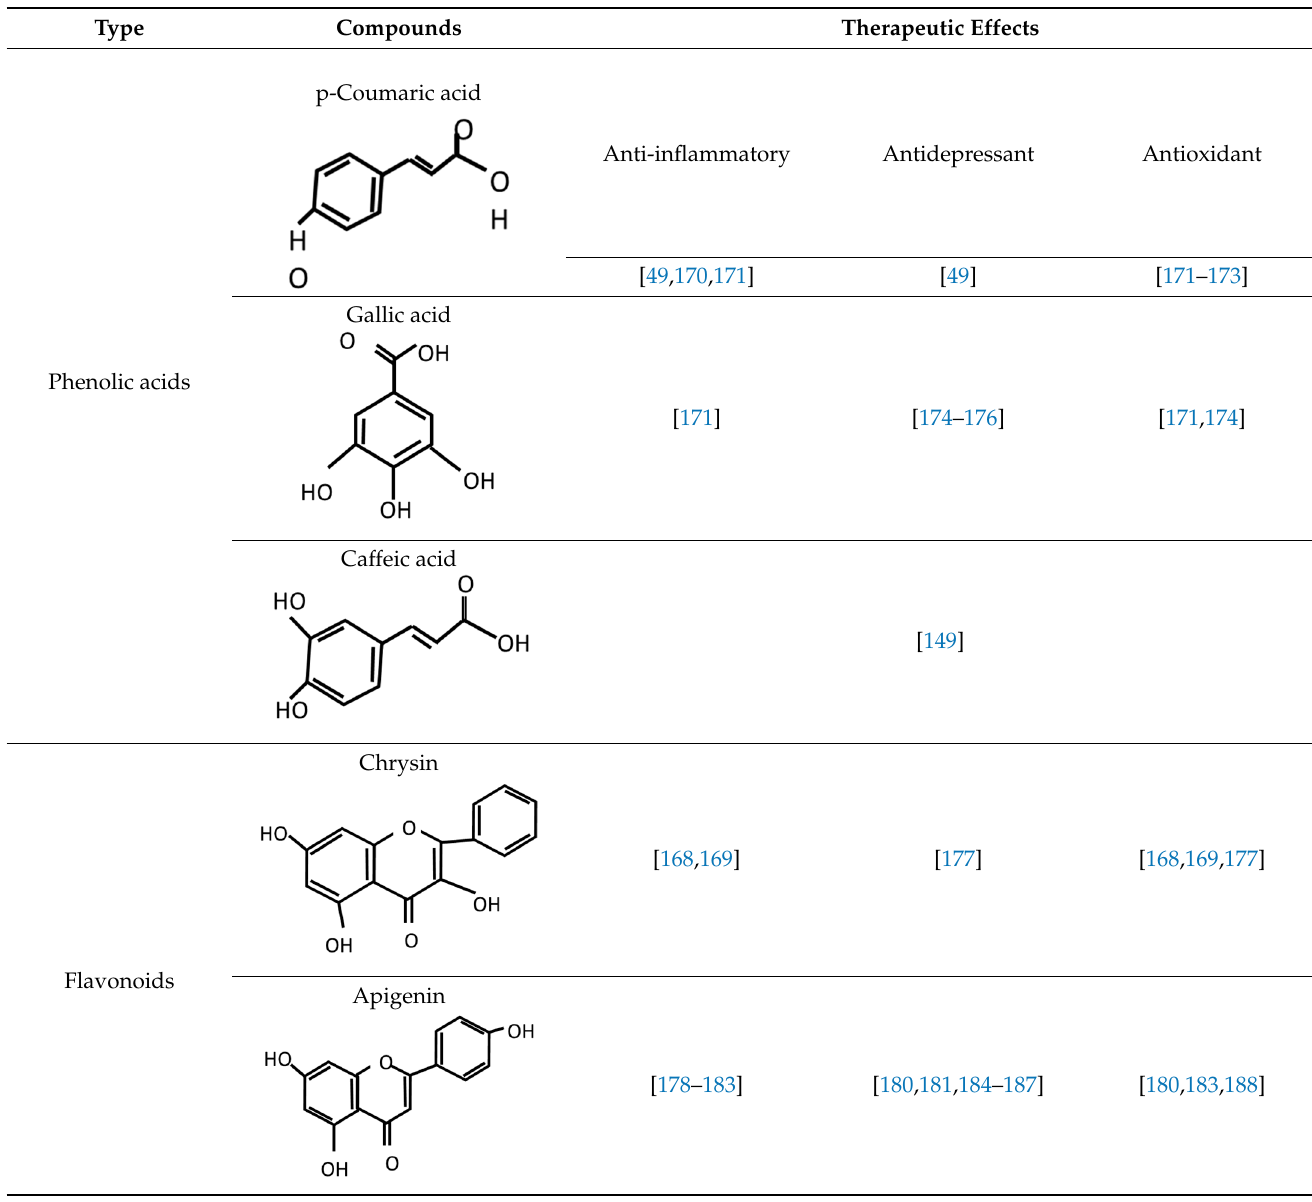
Table 1. Phenolic compounds that showed therapeutic effects on psychiatric and neurological disorders.